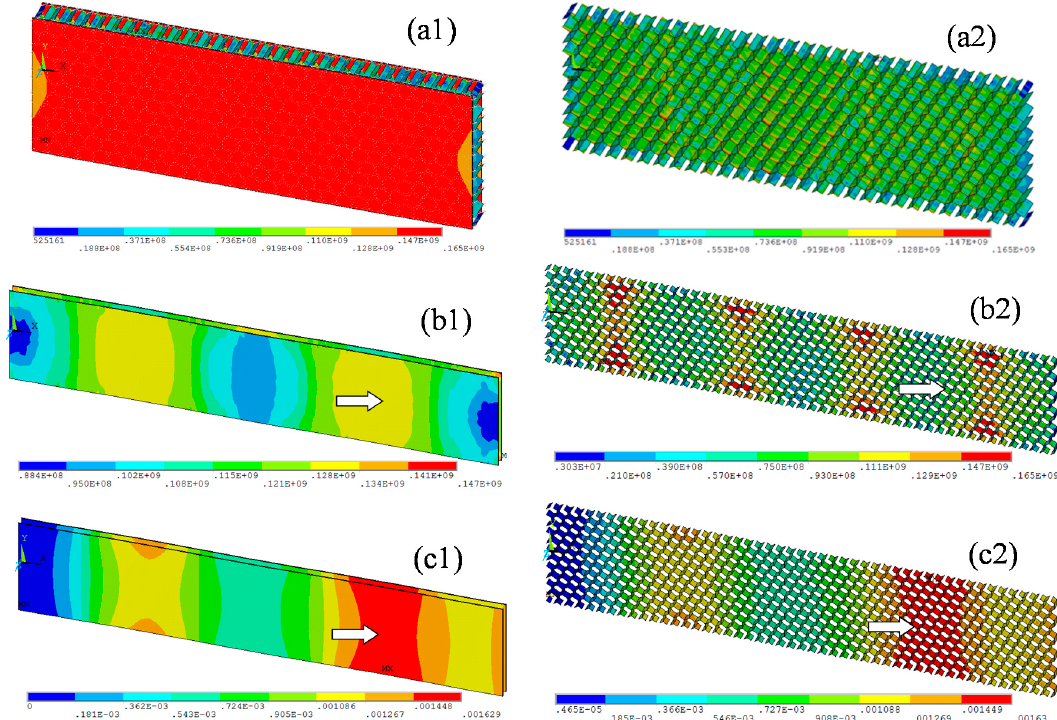
Figure 3. Finite element analysis results of the test pieces. The left column shows the entire panel, and the right column shows the honeycomb core: ( a ) Thick-20; ( b , c ) the stress and displacement plots of Thin-10, respectively.